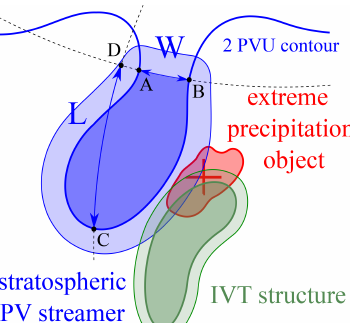
Figure 1. Schematic representation of Rossby wave breaking (stratospheric PV streamer in blue) and intense moisture trans- port (IVT structure in green) as synoptic-scale processes of EPEs (extreme precipitation object in red), adapted from De Vries et al. (2018). The light blue and light green shadings illustrate the area of influence of the synoptic features, and the symbols W and L re- fer to the geometrical criteria of PV streamers, as further detailed in Sect.